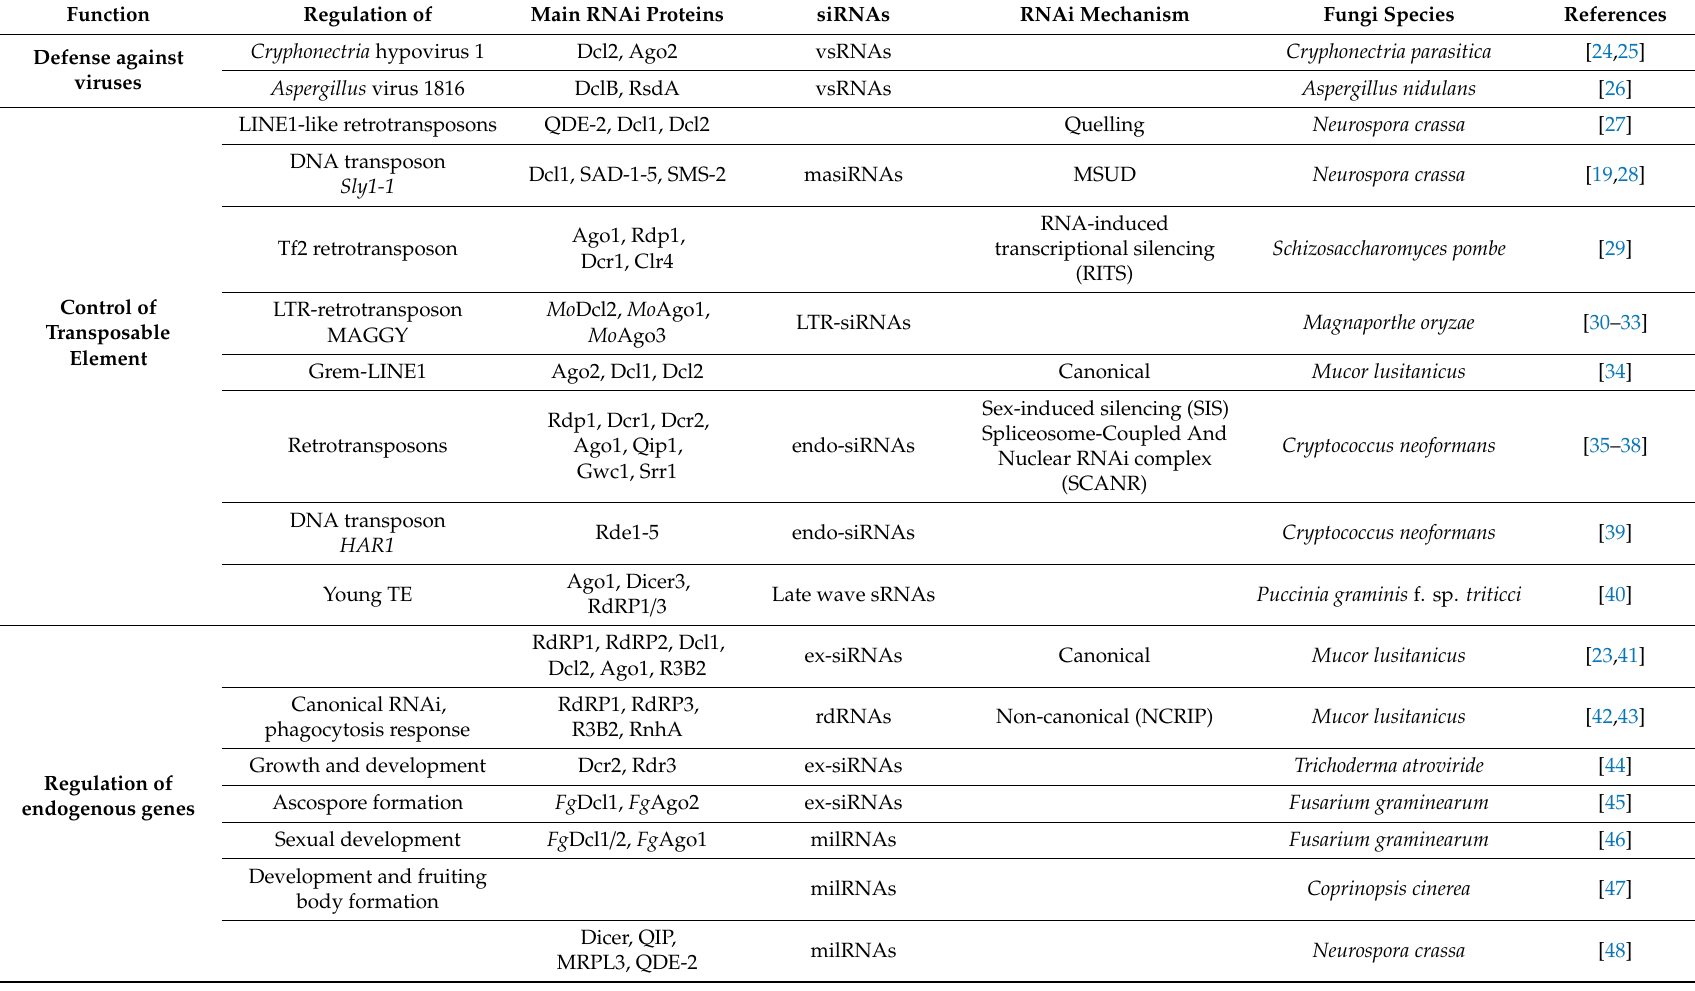
Table 2. Classification of RNA interference (RNAi) mechanisms found in